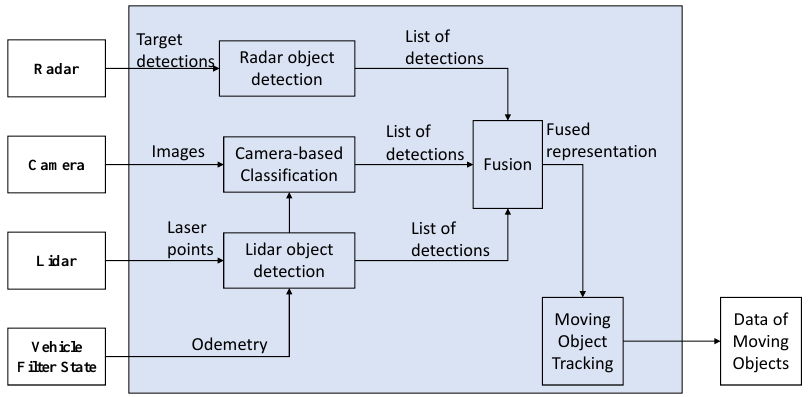
Figure 11. The system with multiple sensors for perception [33].